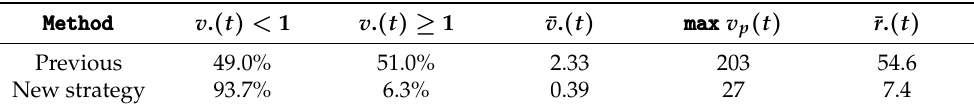
Table 8. Comparison of the vulnerability and risk levels of the patients under control using both prioritization methods. The percentage of patients with vulnerability levels v . ( t ) < 1 and v . ( t ) ≥ 1, and the results of ¯ v . ( t ) , max v . ( t ) , and ¯ r . ( t ) are